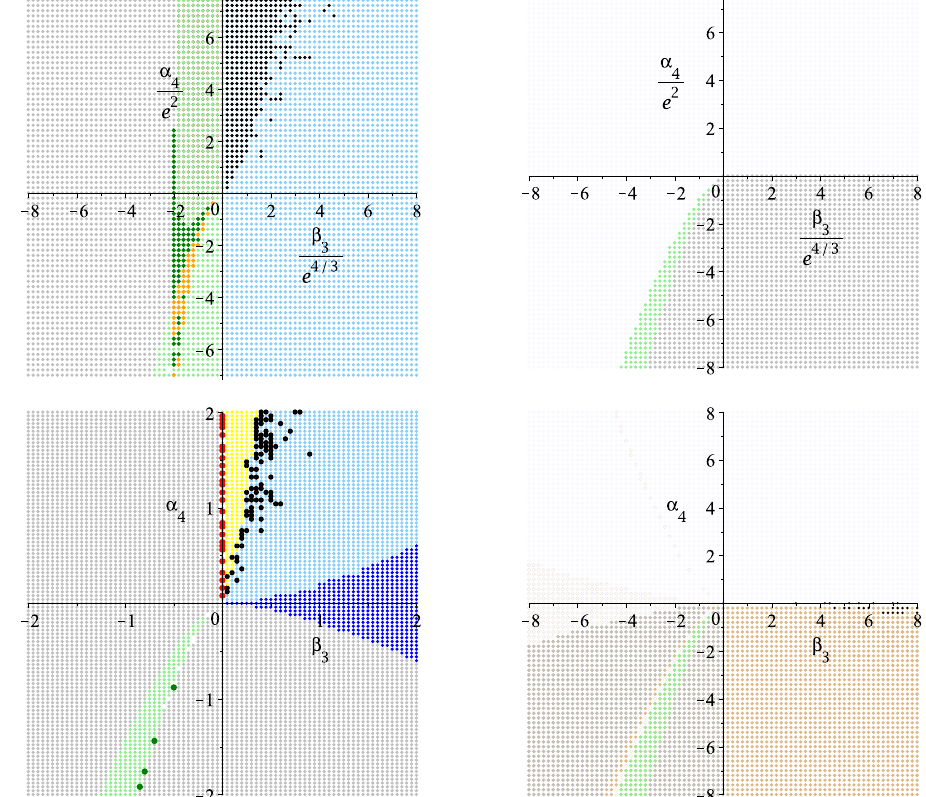
Figure 11 . Number of critical points as a function of couplings in d = 6 (color online). At top left is the spherical k = 1 case, at top right the hyperbolic k = (cid:0) 1 case; at bottom left is the spherical k = 1, e = 0 case, at bottom right the hyperbolic k = (cid:0) 1, e = 0 case, with colour coding given in table 1. Green, dark green, and orange regions respectively indicate one, two, and three physical critical points. Blue regions indicate single critical points with (cid:13) 2 < 0, and black indicate single critical points both S < 0 and (cid:13) 2 < 0. Dark blue, red, and yellow regions respectively indicate (cid:13) 2 < 0, S < 0, and both S < 0 and (cid:13) 2 < 0, but with two critical points. Light brown regions have solutions with no asymptotic positive real value for f 1 . Grey regions have no critical points, and white regions indicate negative